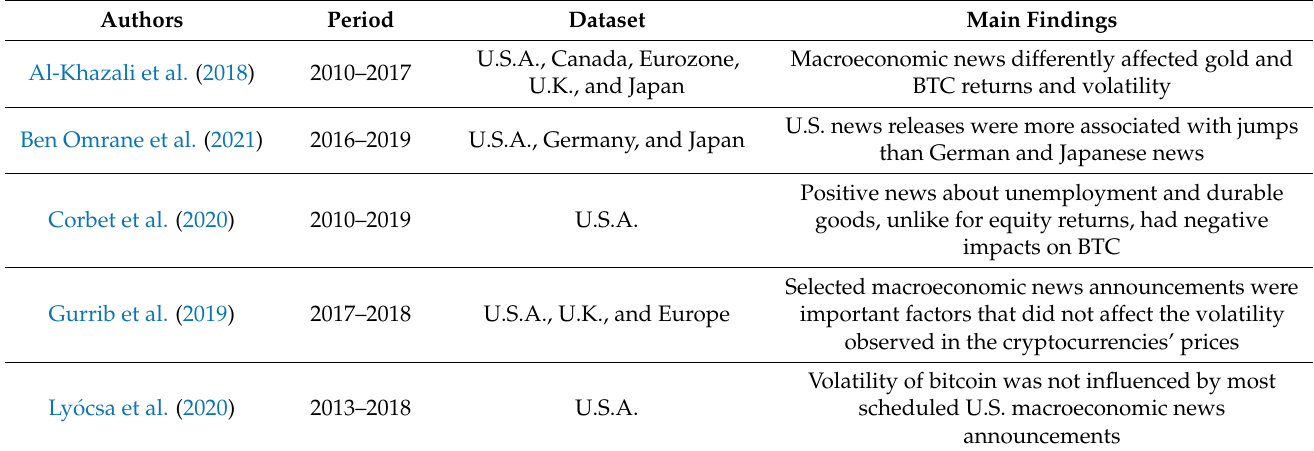
Table 1. Studies of the impact of macroeconomic news/announcements on